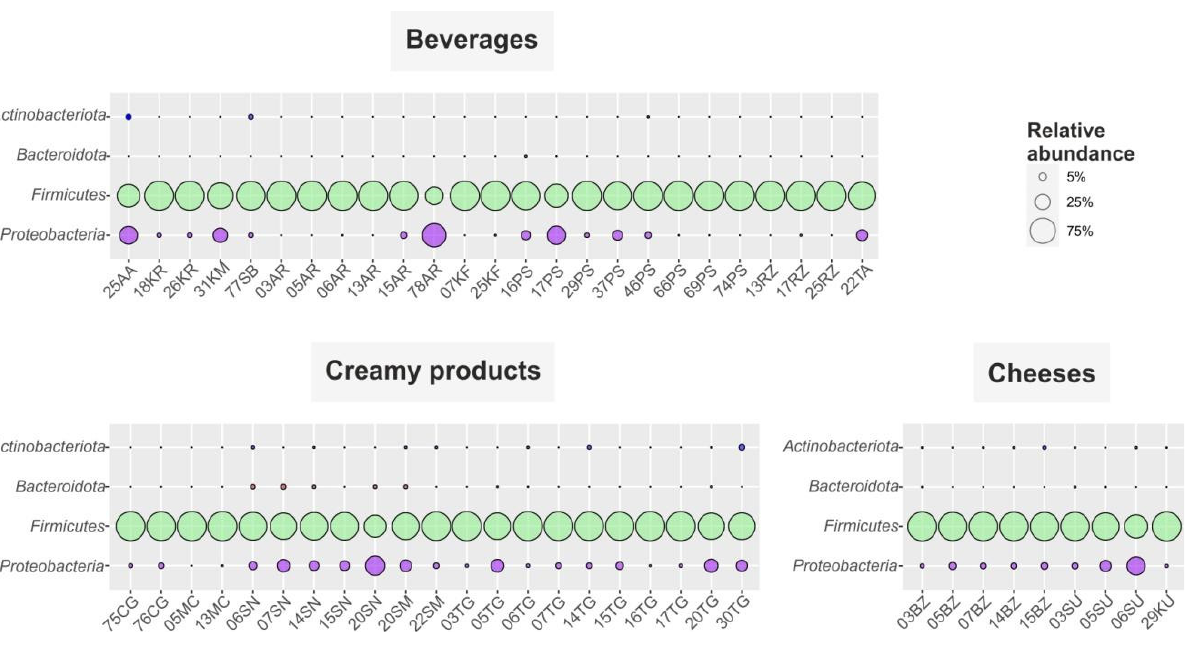
Figure 3. Distribution of FMPs microbial communities on the phylum level. Only phyla containing genera, which made up ≥ 0.5% of total microbial community for at least one sample, are shown.